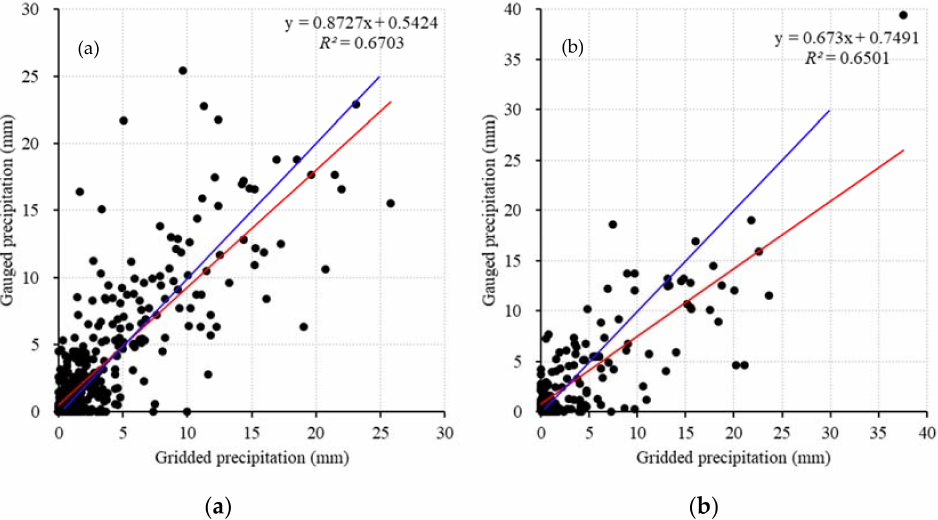
Figure 3. Scatter diagram of daily gauge precipitation and daily gridded precipitation in Hulugou ( a ) and Arou sunny slope ( b ) (red line, trend line; blue line, 1:1 line).